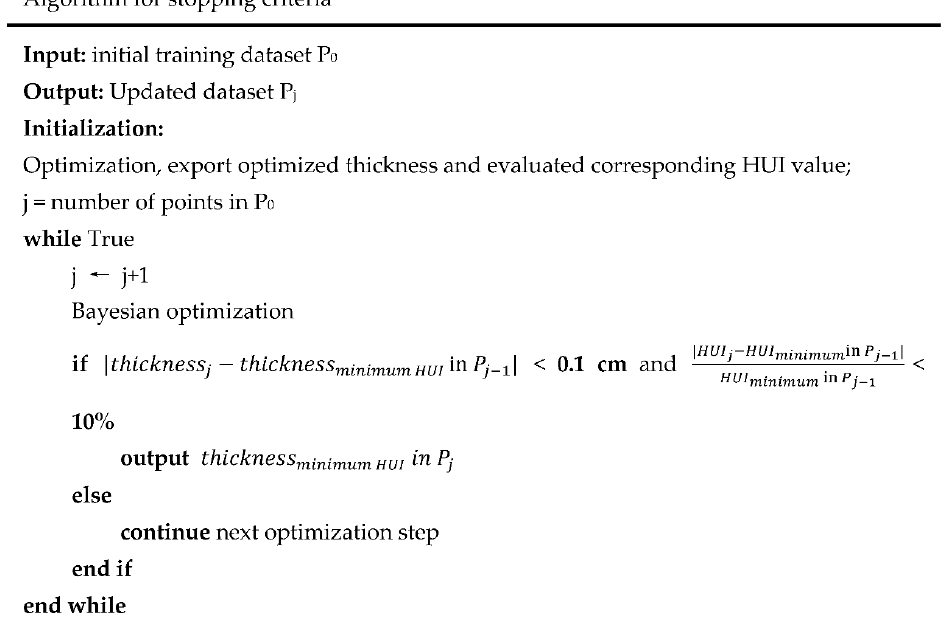
Figure 4. Pseudocode depicting the algorithm for stopping the integrated mechanistic-modeling and machine-learning process.